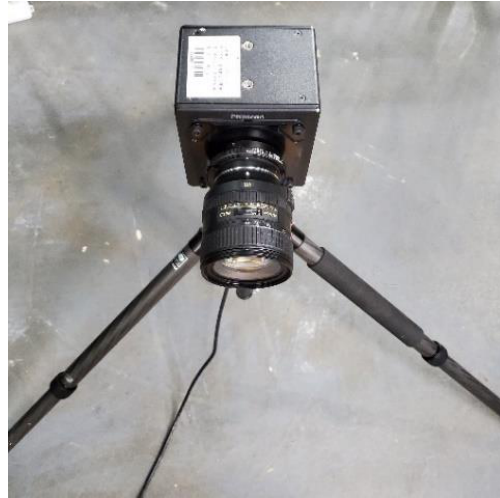
Figure 4. High-speed photography.